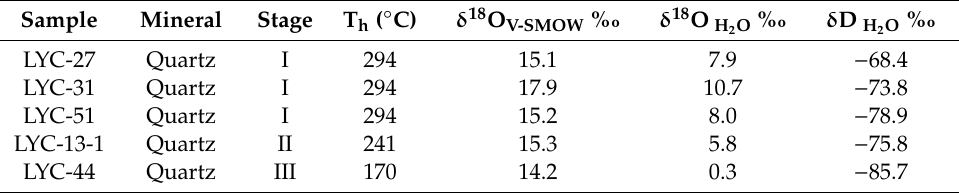
Table 2. Hydrogen and oxygen isotope compositions for di ff erent stages analyzed in this study. Sample Mineral